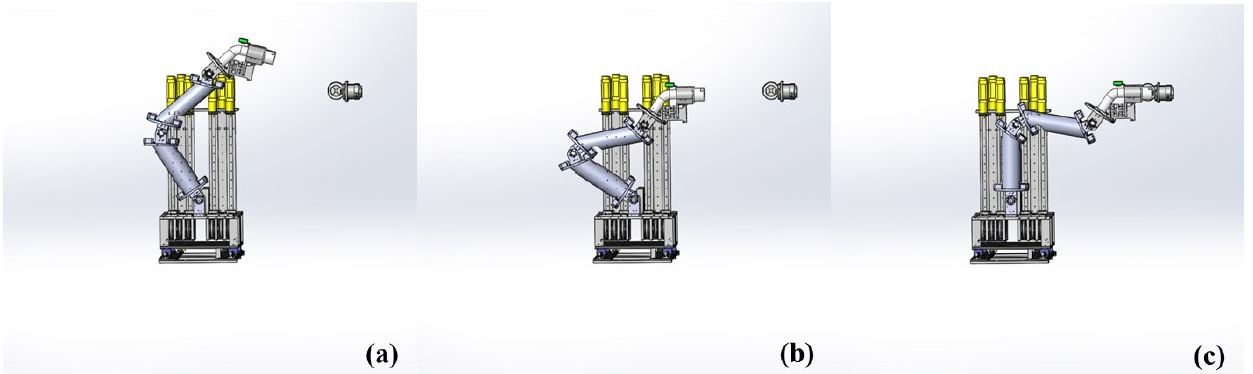
Figure 1. ( a ) The process of charging port localization; ( b ) the pre-insertion stage; ( c ) the process of inserting the charger into the charging port or plugging out the charger.